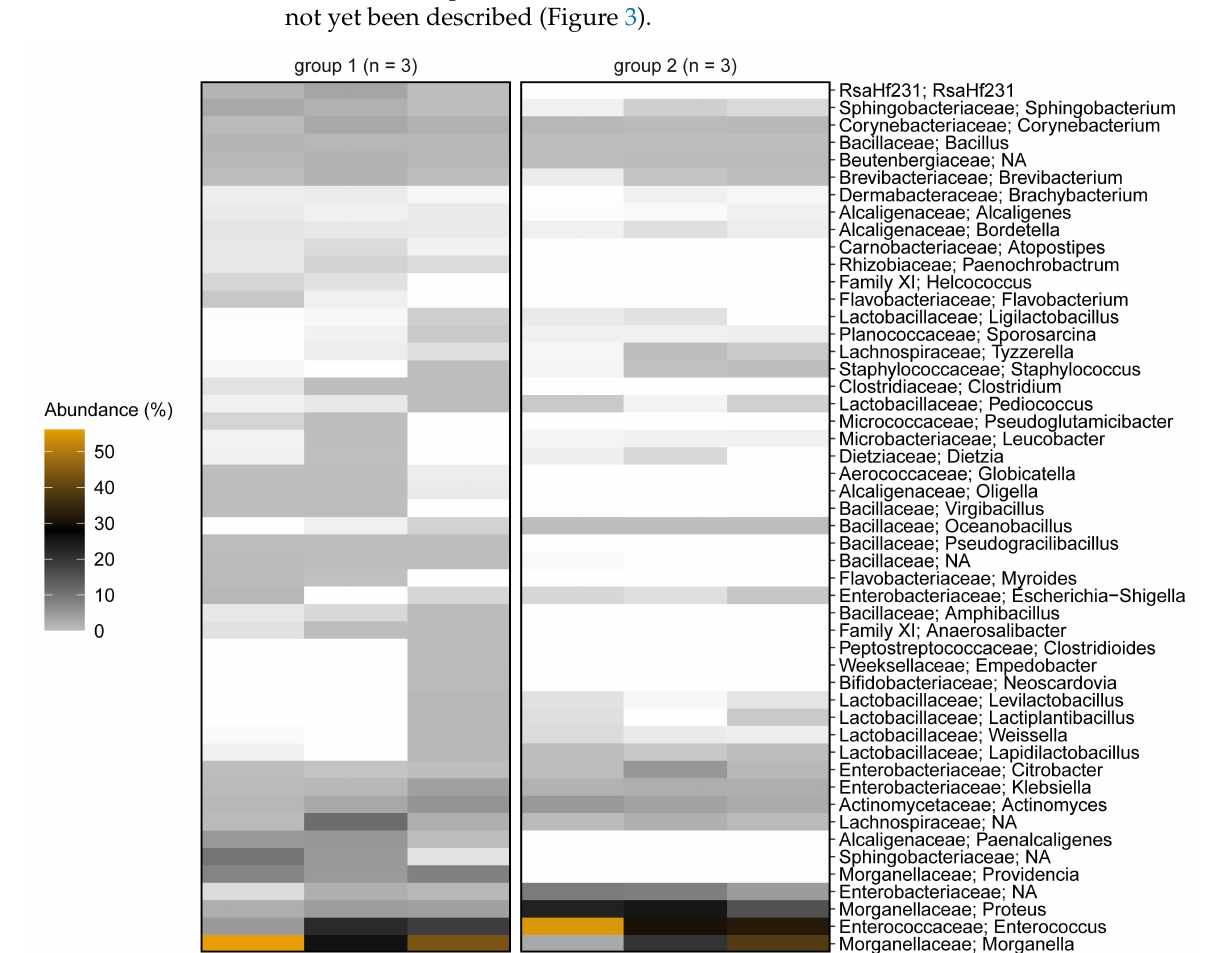
Figure 2. Heat map showing the bacterial communities in the BSFL guts representing group 1 (G1) and group 2 (G2) larvae, based on 16S rRNA gene amplicon sequencing. The relative abundances of ASV counts are collapsed to the genus level for all replicates. Family assignments are prefixed. Percentage relative abundance is color-coded from light gray, through black, to orange, the last representing the highest abundance. Families depicted in white were not detected in the sample. Only the top 50 genera are shown, measured by the mean counts per genus level over all samples. Genera Clostridium sensu stricto 1, 15 and 18 are collapsed to the genus Clostridium . Genera with undefined family and genus are not